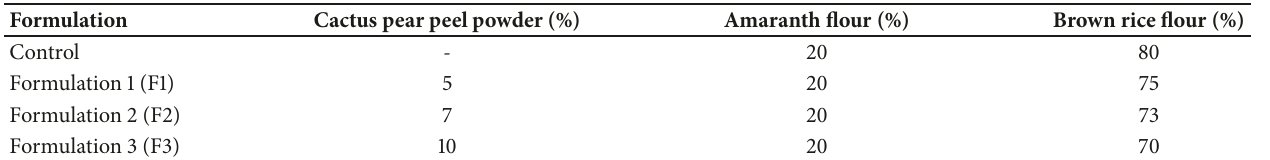
Table 2: Snacks formulation.